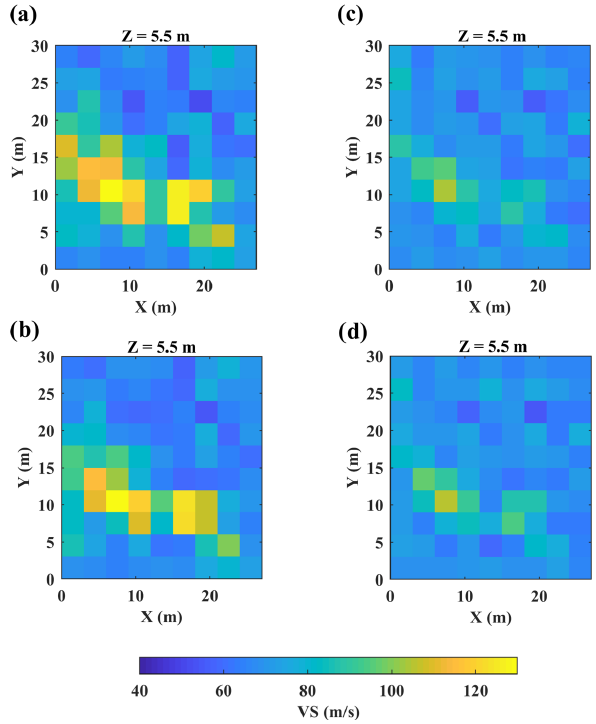
Figure 17. The impact of weighting on the SWT inversion re- sults for the Pijnacker dataset. The computed VS model at the depth of 5.5m from (a) weighted straight-ray, (b) weighted curved- ray, (c) non-weighted straight-ray and (d) non-weighted curved-ray